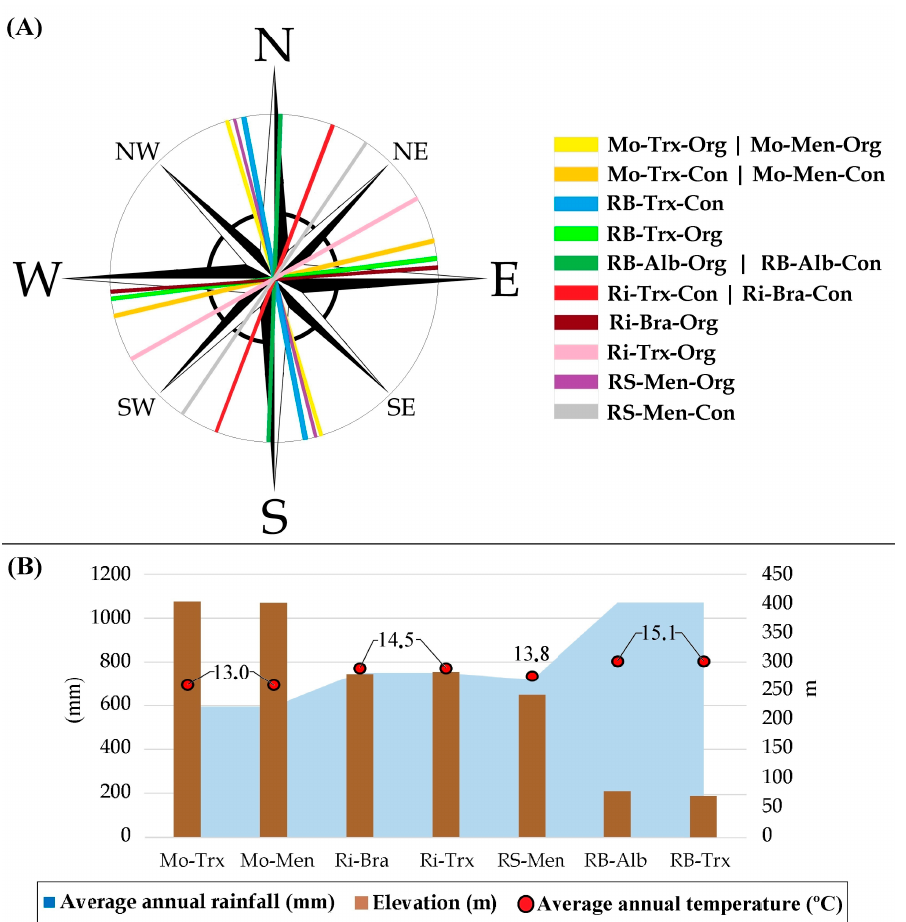
Figure 3. ( A ) Orientation and ( B ) elevation, average annual rainfall, and average annual tempera- ture of each vineyard during 2015. Designations of Origin (DOs: Monterrei, Mo; R í as Baixas, RB; Ribeira Sacra, RS; Ribeiro, Ri); culture system (Organic, Org; Conventional, Con); grapevine varieties (Albariño, Alb; Brancellao, Bra; Menc í a, Men; Treixadura,